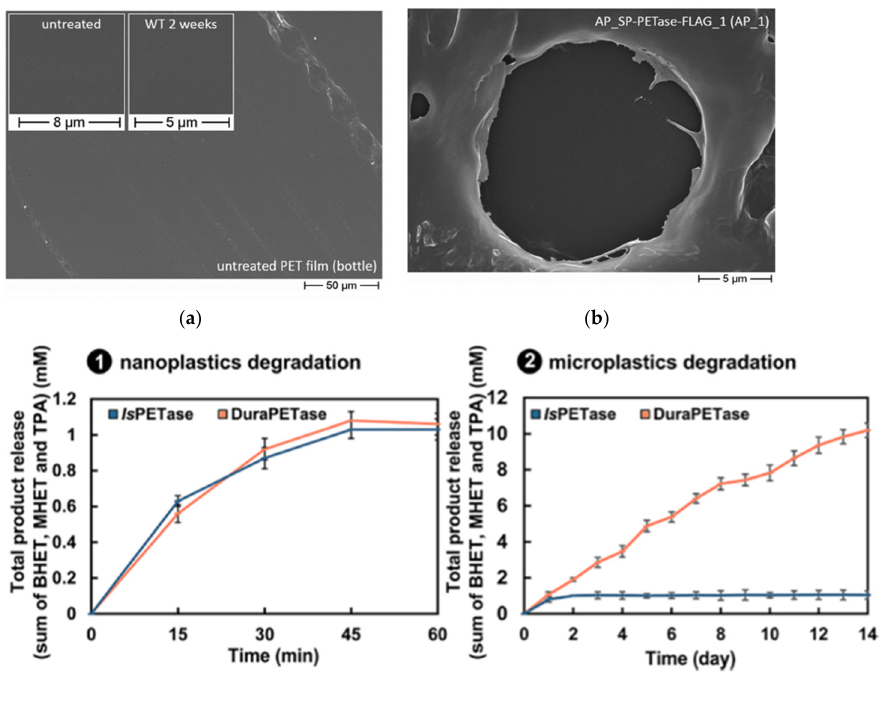
Figure 2. ( a ) Untreated PET film, as seen via scanning electron microscopy, and representative of the standard, smooth surface of a PET-based bottle film. Reprinted with permission from ref. [43]. 2019 Springer Nature. ( b ) Scanning electron microscopy analysis of PET bottle film following five weeks of exposure to and subsequent degradation by cells expressing AP SP _PETase R280A − FLAG; degradation is shown as a sign of wear. Reprinted with permission from ref. [43]. 2019 Springer Nature. ( c ) Plots corresponding the total sum of the concentration of PET degradation products with time following the respective nanoplastics’ and microplastics’ incubation with Is PETase and DuraPETase. Reprinted with permission from ref. [45]. 2021 American Chemical Society.